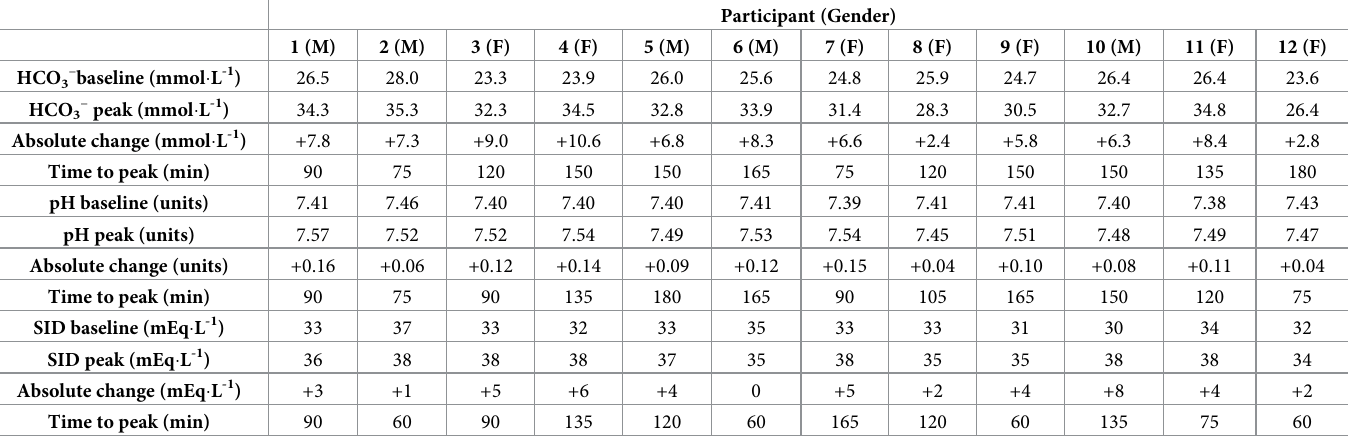
Table 3. Individual metabolite responses to 0.3 g � kg BM -1 sodium bicarbonate (NaHCO 3 ).